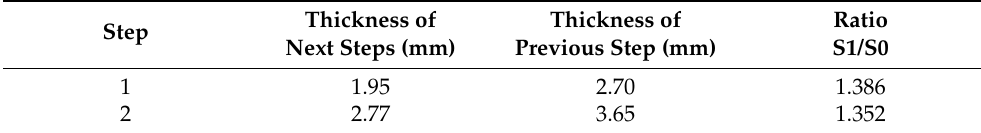
Figure 4. Simulation of the forming process via one step. Table 1. Thickness distribution of the forming